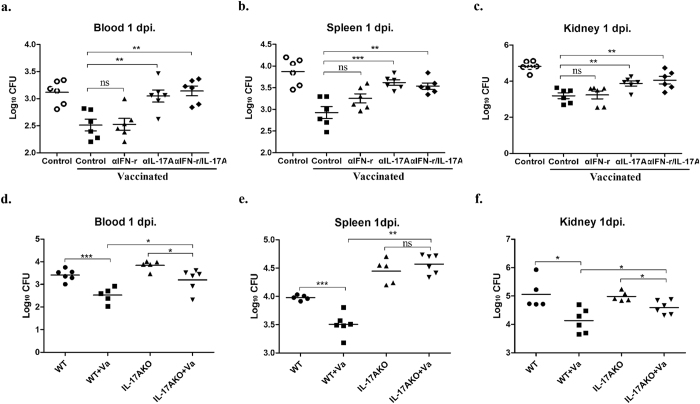
Impact of IFN-γ and/or IL-17A neutralisation on bacterial burdens in the protective effects of IC vaccination.Vaccinated BALB/c mice were injected with αIFN-γ, αIL-17A, or both at 2 days before infection. The unvaccinated mice or untreated vaccinated mice regarded as control or vaccinated control. Bacterial burdens were calculated in the blood (a), spleens (b) and kidneys (c) 3 days post-infection. (d–f) IL-17KO and WT mice were immunised as described before, the bacterial burdens were monitored 3 days post-infection. Data are presented as scatter plots, and the medians were shown. Asterisks indicate significant differences between vaccinated and control mice. Results represent three independent experiments (*P < 0.05, **P < 0.01, ***P < 0.001).